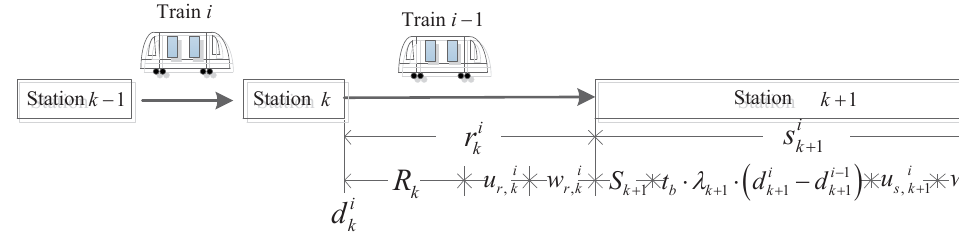
Figure 1. Illustration of the train traffic